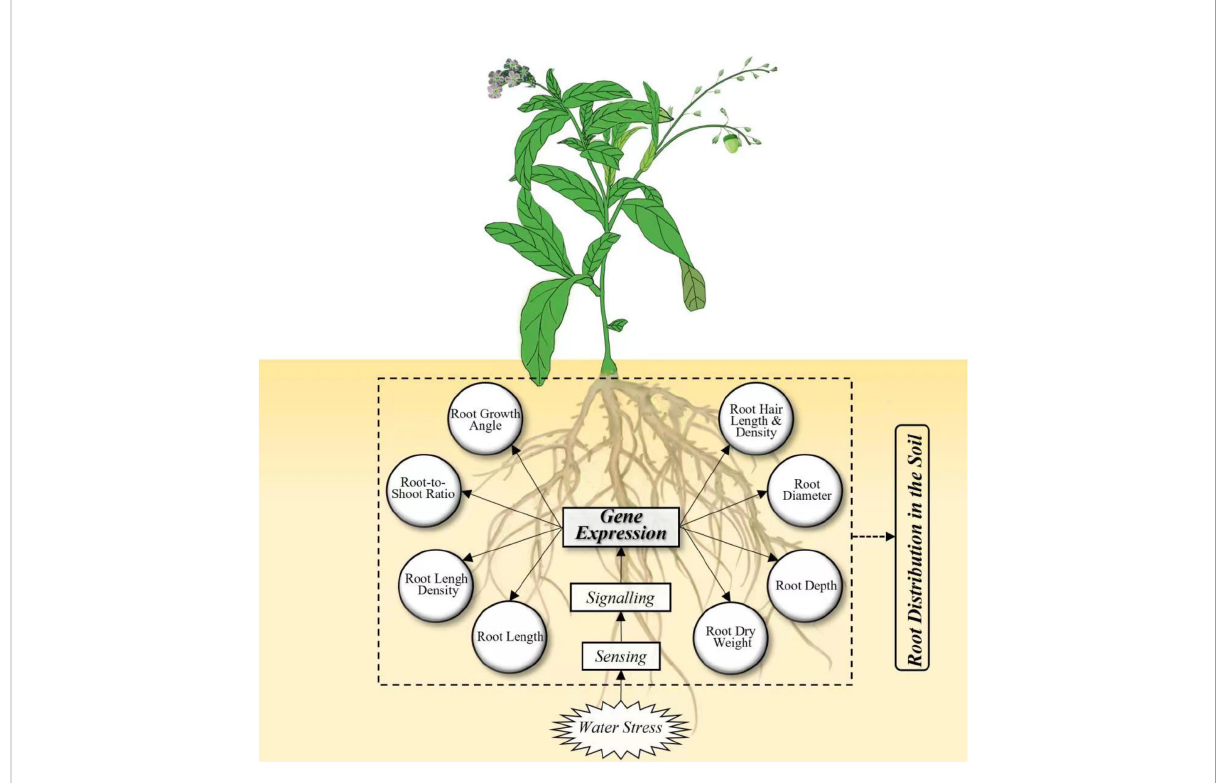
FIGURE 1 Framework integrating the root responses to water stress at genetic and morphological